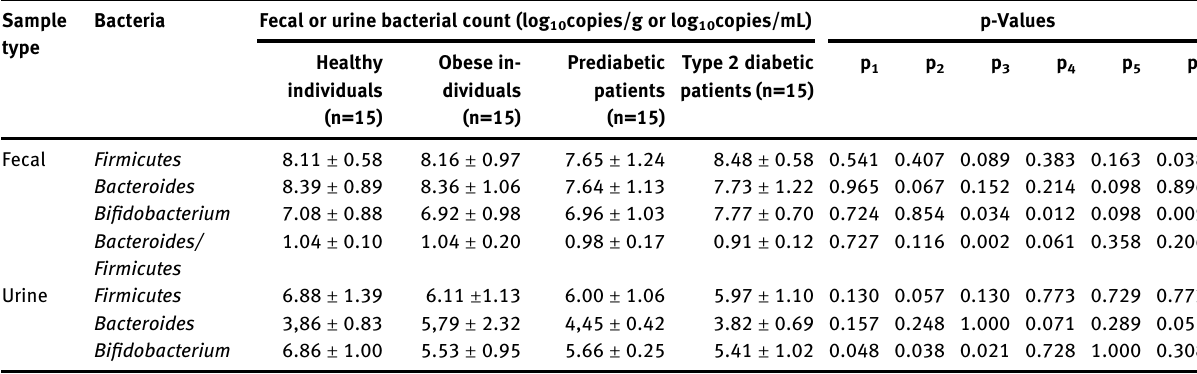
Table  : Statistical results of the microbiota of all groups. Sample